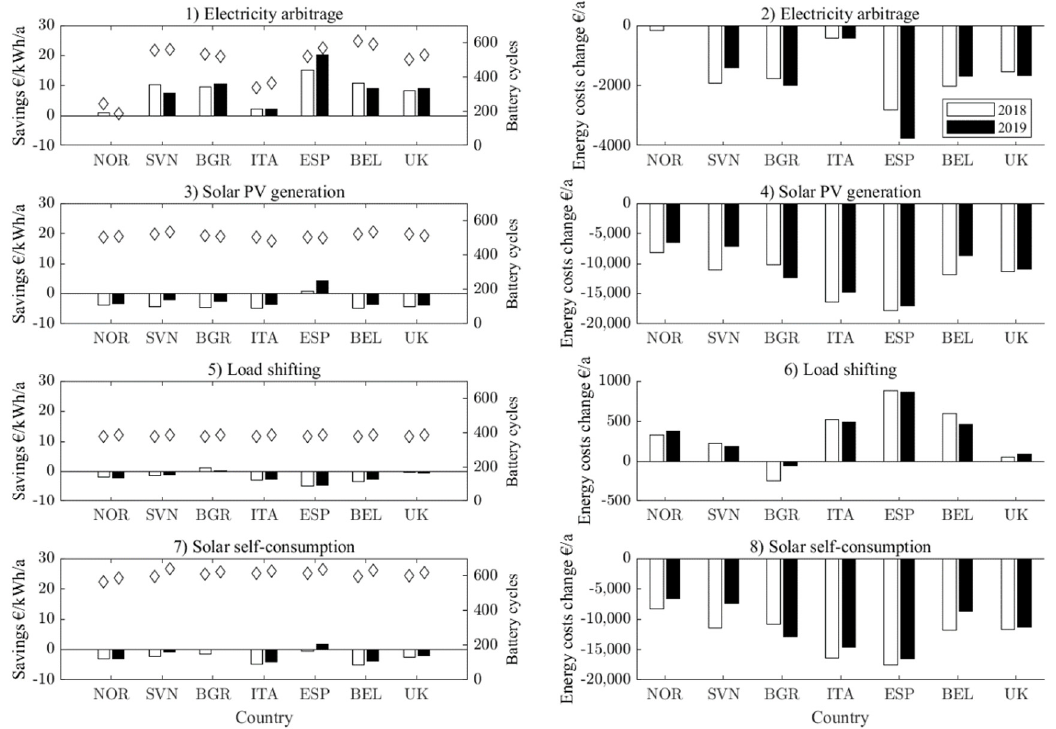
Figure 2. Direct economic savings due to the battery system and number of battery cycles (diamond shape) to the left, and the total changes in energy costs per year to the right for each scenario for year 2018 (white) and 2019 (black).